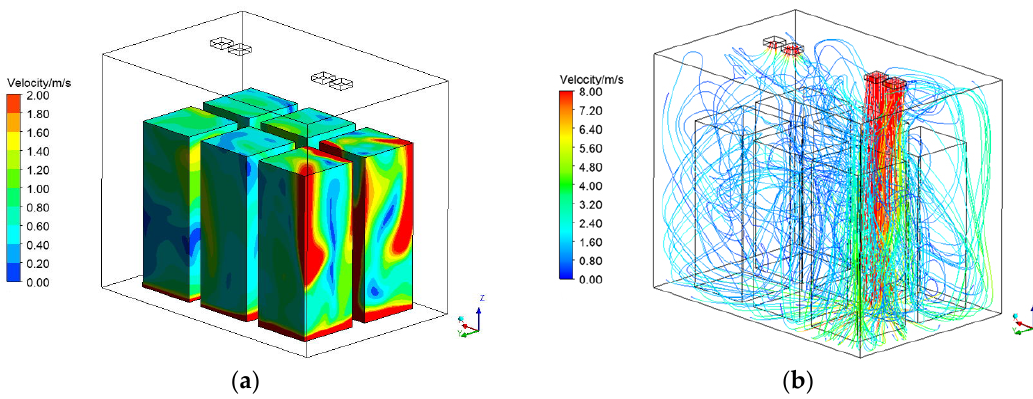
Figure 7. ITCC velocity distribution. ( a ) Velocity distribution on the produce surface and ( b ) container streamlines.